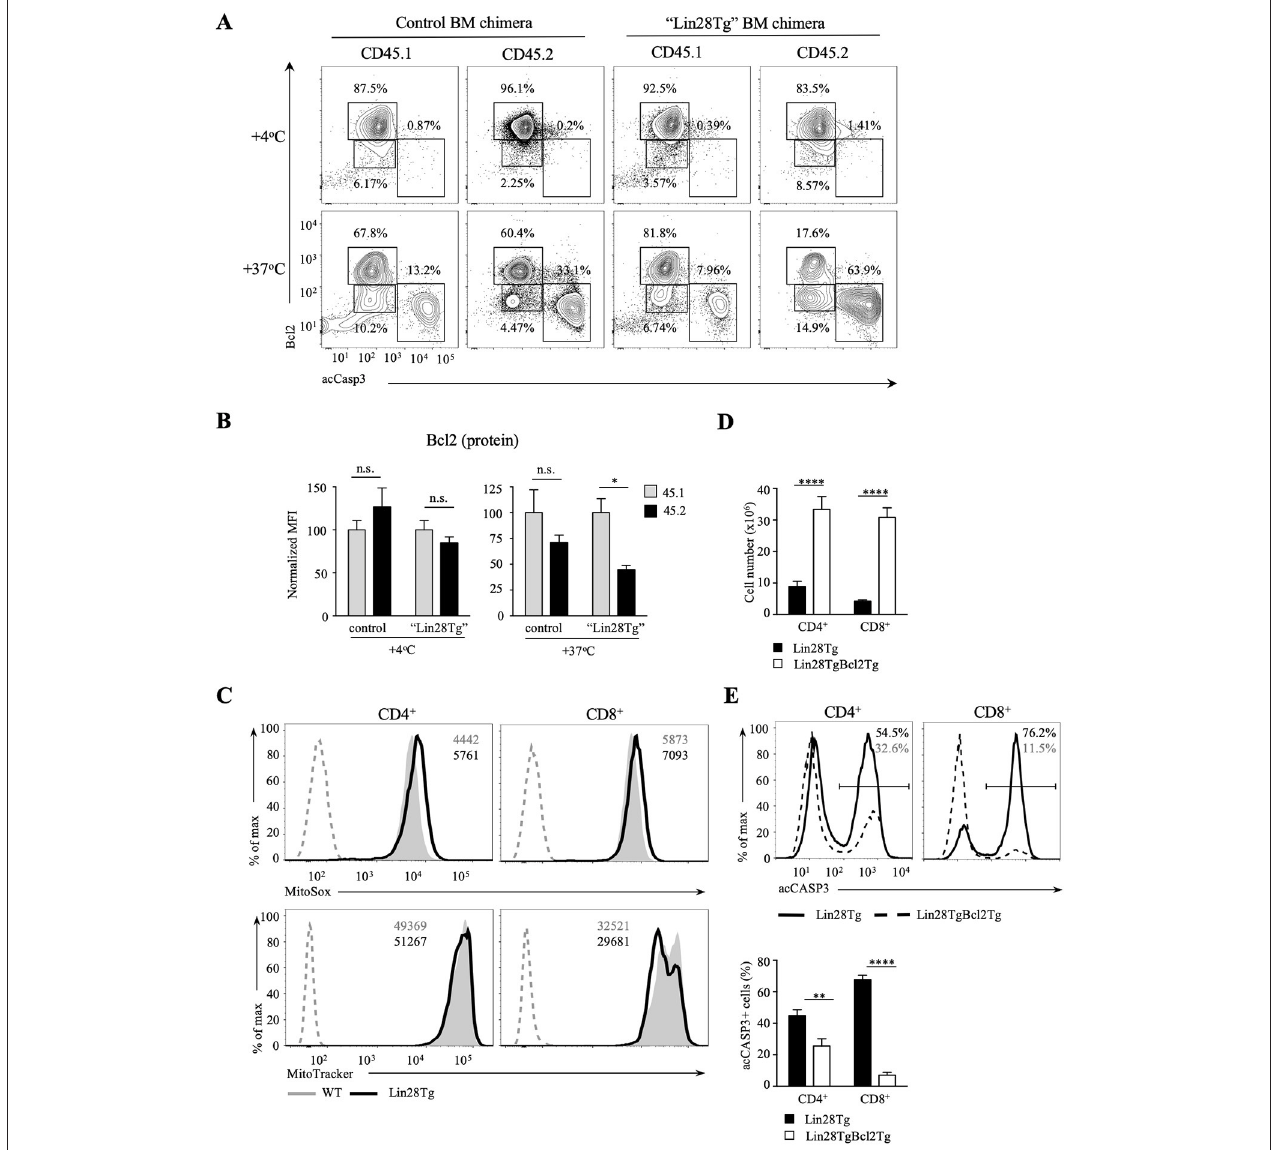
FIGURE 5 | Bcl2 rescues cell death in let-7-deficient T cells. (A) Intracellular staining for Bcl2 and active Caspase-3 in CD8 lymph node T cells from control and “Lin28Tg” mixed BM chimeras cultured for 18h in media. (B) MFI of Bcl2 in acCasp3 negative populations from CD8 lymph node T cells from control ( n = 3) and “Lin28Tg” ( n = 3) mixed BM chimeras cultured for 18h in media. (C) Staining of fresh CD4 and CD8 lymph node T cells from wild type and Lin28Tg mice for mtROS (top) and mitochondria (bottom). MFIs of MitoSox and MitoTracker are shown. Dashed histogram shows unstained control. (D) Total number of CD4 and CD8 lymph node T cells recovered from Lin28Tg ( n = 5) and Lin28TgBcl2Tg ( n = 2) mice. (E) Intracellular staining for active Caspase-3 (top) and frequency of acCasp3 + population (bottom) in CD4 and CD8 lymph node T cells from Lin28Tg and Lin28TgBcl2Tg mice. Data are from three (A–C) and two (D,E) independent staining experiments. Data in (B–D) are displayed as mean ± SEM; n.s., not significant ( p > 0.05), * p < 0.05, ** p < 0.01, **** p <